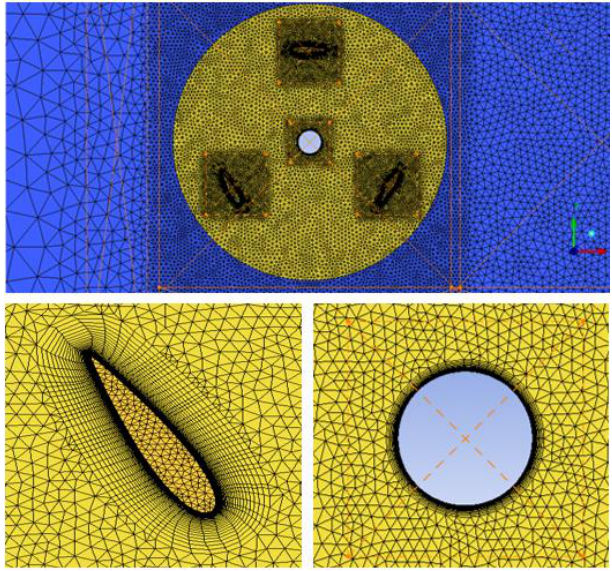
Figure 2. Detail of the prism layer on the turbine blade and shaft.